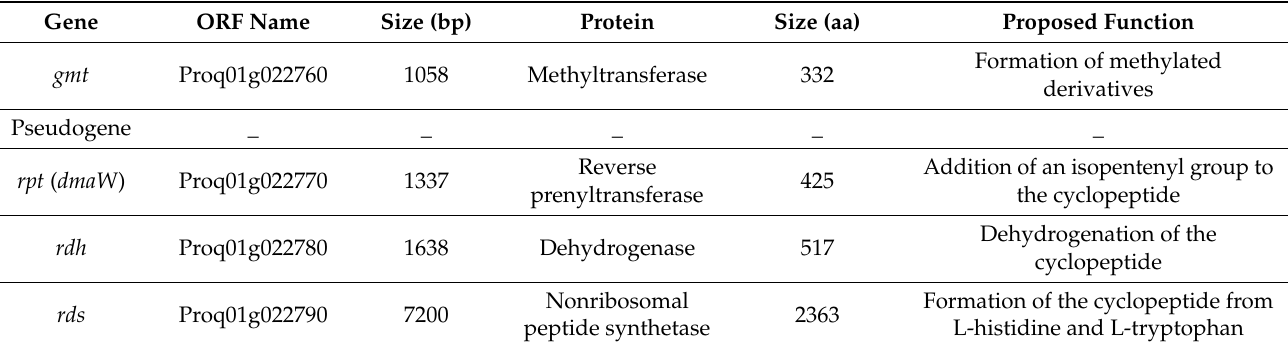
Table 1. Roquefortine C biosynthetic gene cluster in P. roqueforti